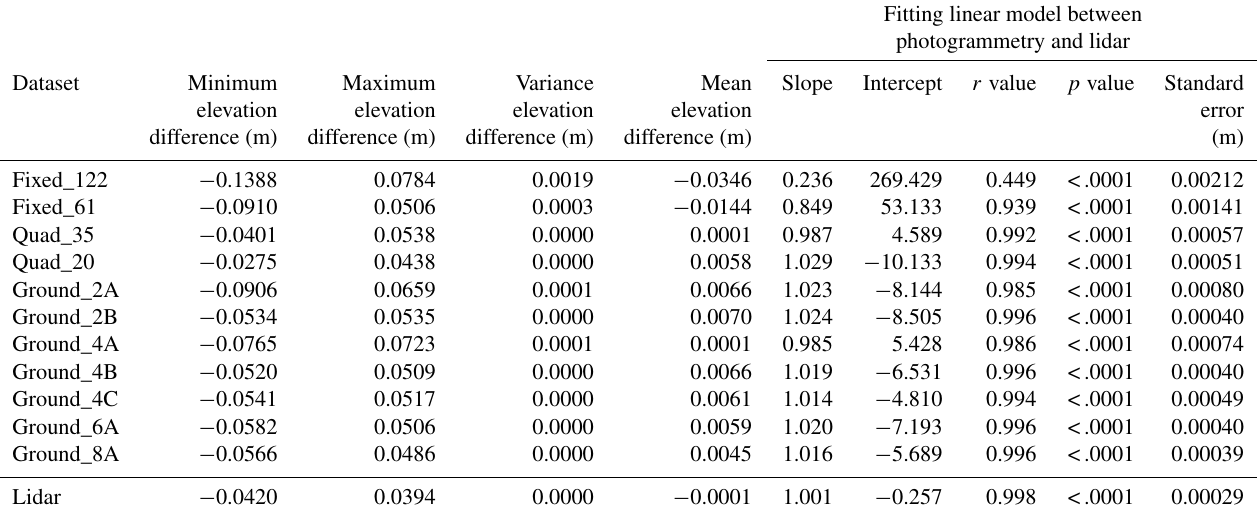
Table 4. Statistics comparing photogrammetry and terrestrial lidar using the point vertical spot to TIN approach ( z direction). Residual values were calculated based on the elevation difference of all raster grid cells.